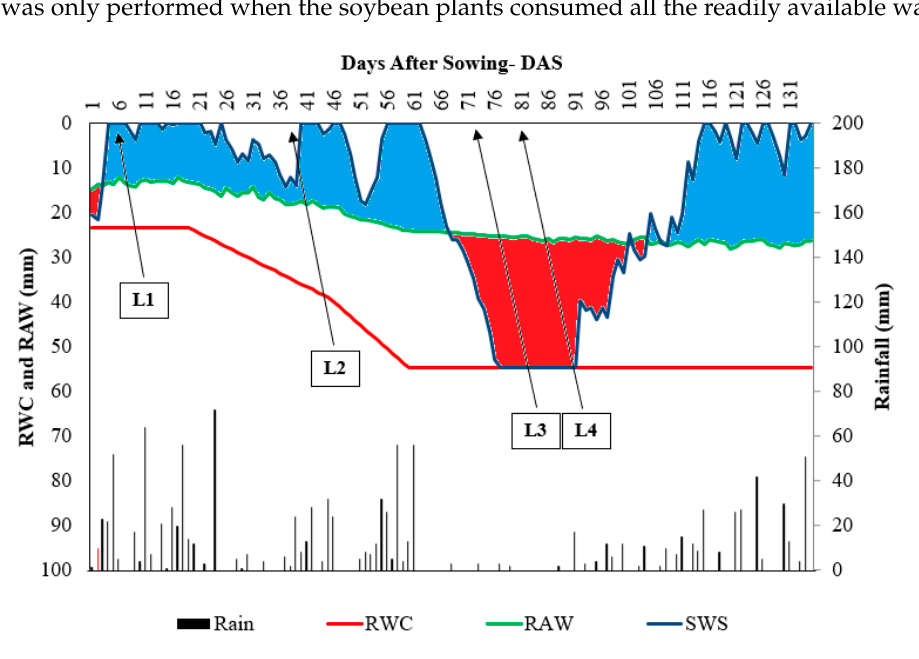
2). The recorded data were corrected for clayey soil, as recommended by Gava et al. [29].